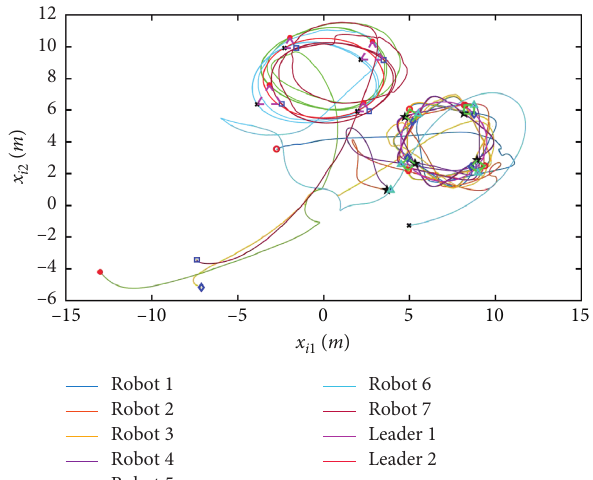
Figure 13: Task-space time-varying formation tracking performance of the NHRS shown in the XY plane in Example 2.